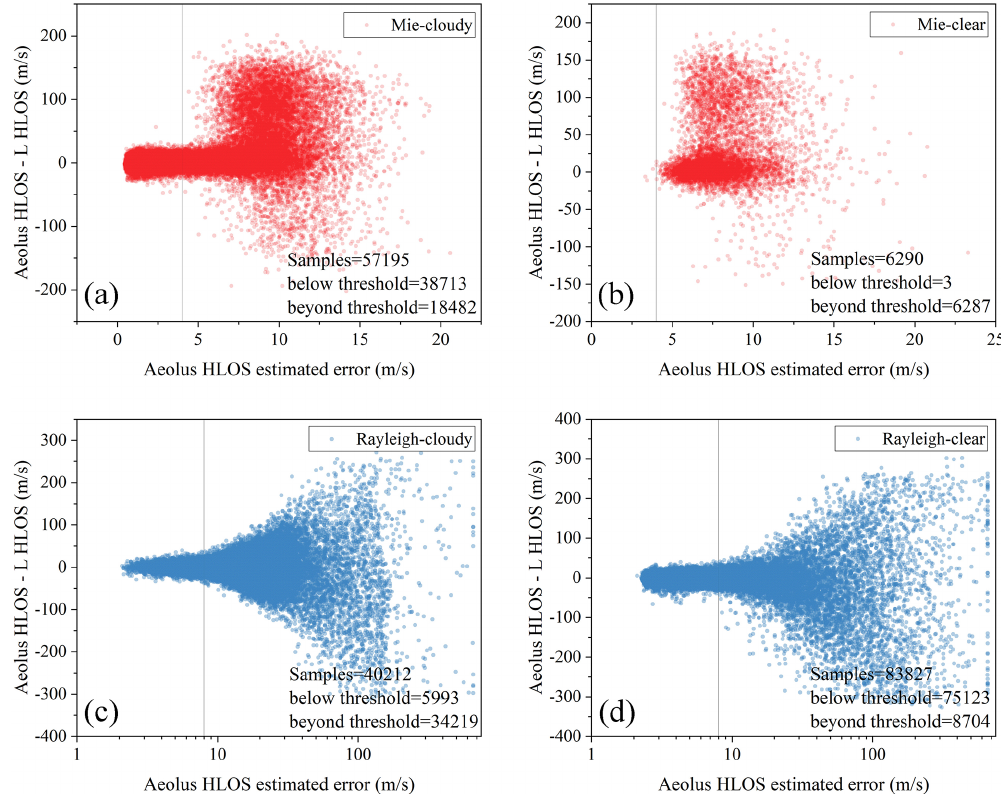
Figure 1. Difference between the Aeolus HLOS and L HLOS wind components as a function of estimated errors for (a) Mie-cloudy, (b) Mie- clear, (c) Rayleigh-cloudy, and (d) Rayleigh-clear. Samples mean the number of data points, and the samples below or beyond the threshold are also listed. Reference lines are the screening threshold of estimated errors: 4ms − 1 (Mie) and 8ms − 1